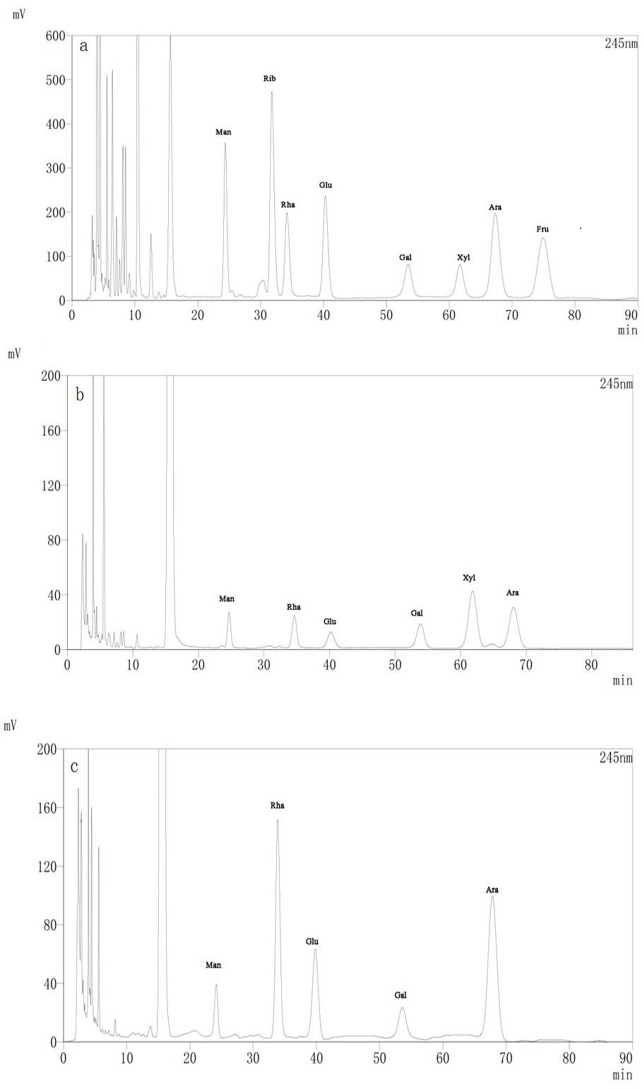
HPLC chromatograms of the PMP derivatives of the monosaccharide standards (a) and the hydrolysates of MLP-1 (b) and MLP-2 (c).